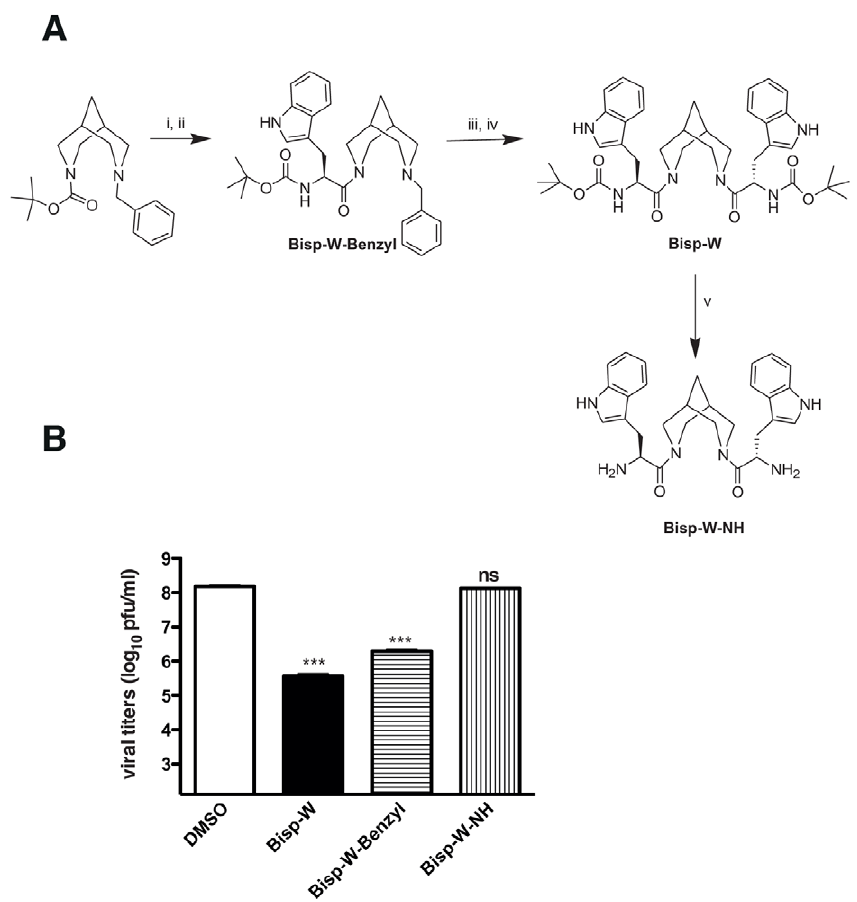
Figure 4. Synthesis of Bisp-W derivatives and its effect on JEV. (A) Structure of Bisp-W derivatives with tryptophan on one arm of bispidine and benzyl on the other (Bisp-W-Benzyl) and with Boc group deprotected (Bisp-W-NH). (B) Viral titers were determined by plaque assay of N2A cell culture supernatants (22 h pi) infected with JEV and treated with 5 m M derivatives of Bisp-W as indicated. *** P=0.0003 and 0.0004 and ns: not significant (P=0.425) as determined by two-tailed, t-test. Error bars represent Mean 6 SEM of three replicates. Data are representative of experiments performed twice with three replicates.